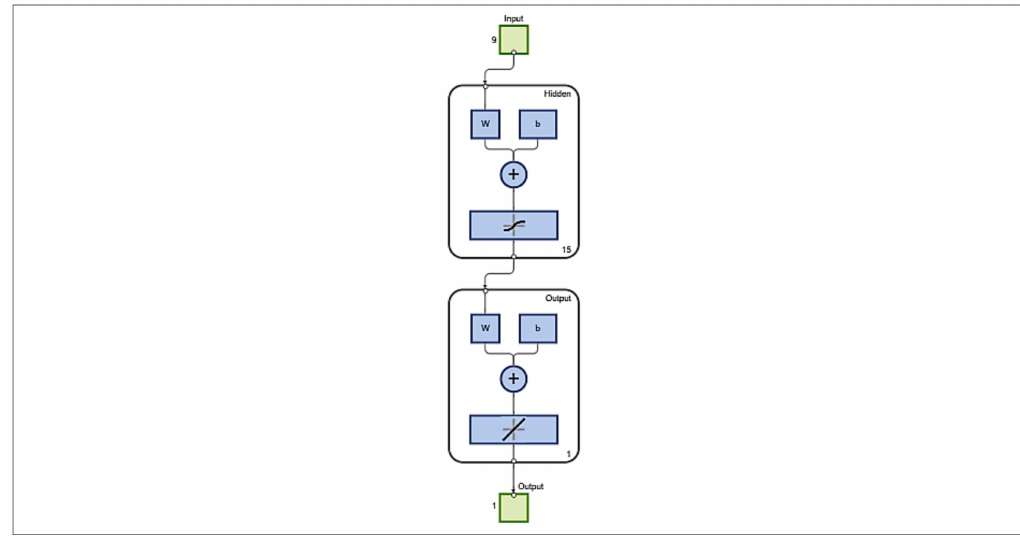
Figure 15. ANN Framework for two-layered feed-forward network.